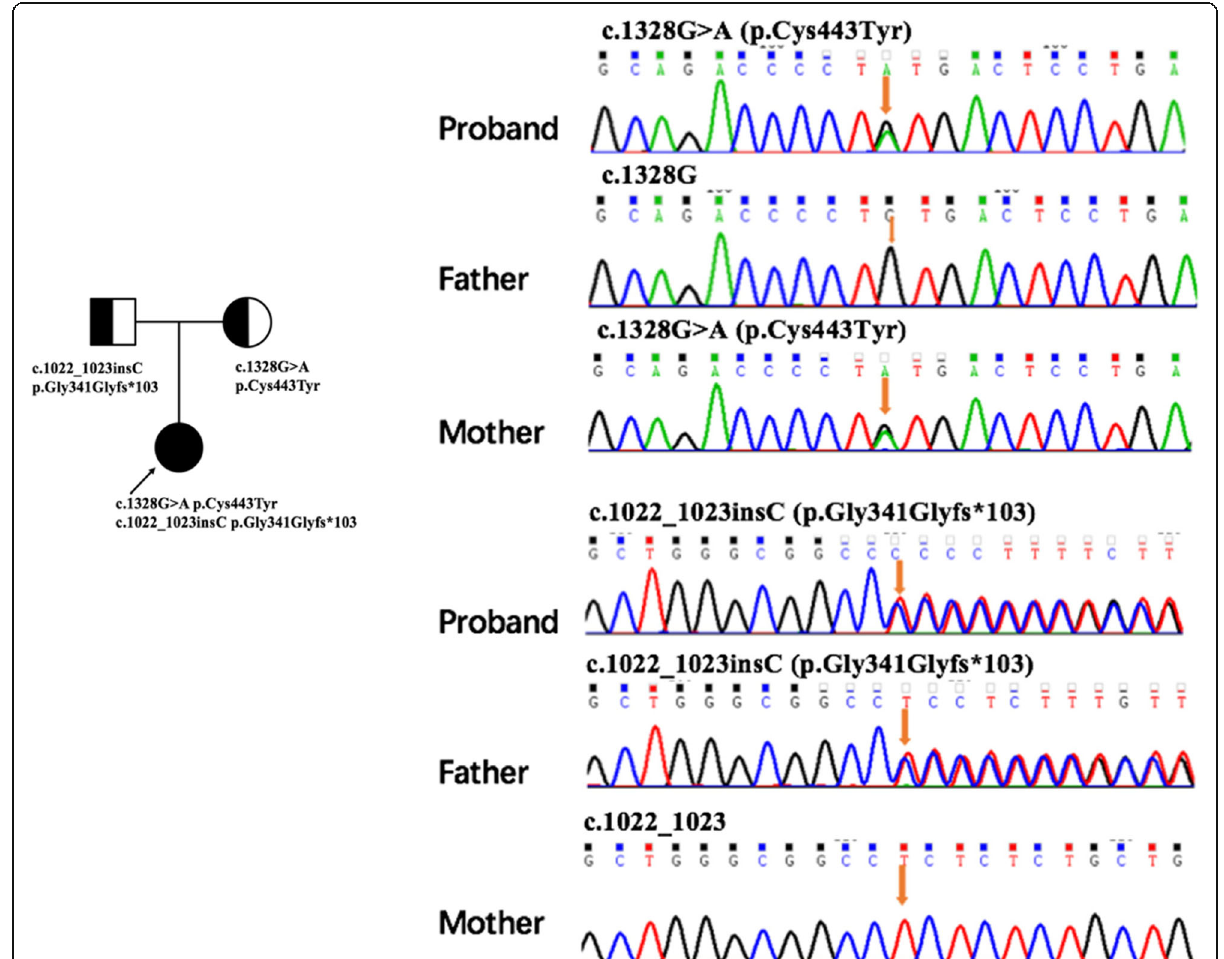
Fig. 1 The genogram of this family and the variants of SLC52A2 c.1328G>A, p.Cys443Tyr, and c.1022_1023insC, Leu341Profs*103 in BVVLS proband and